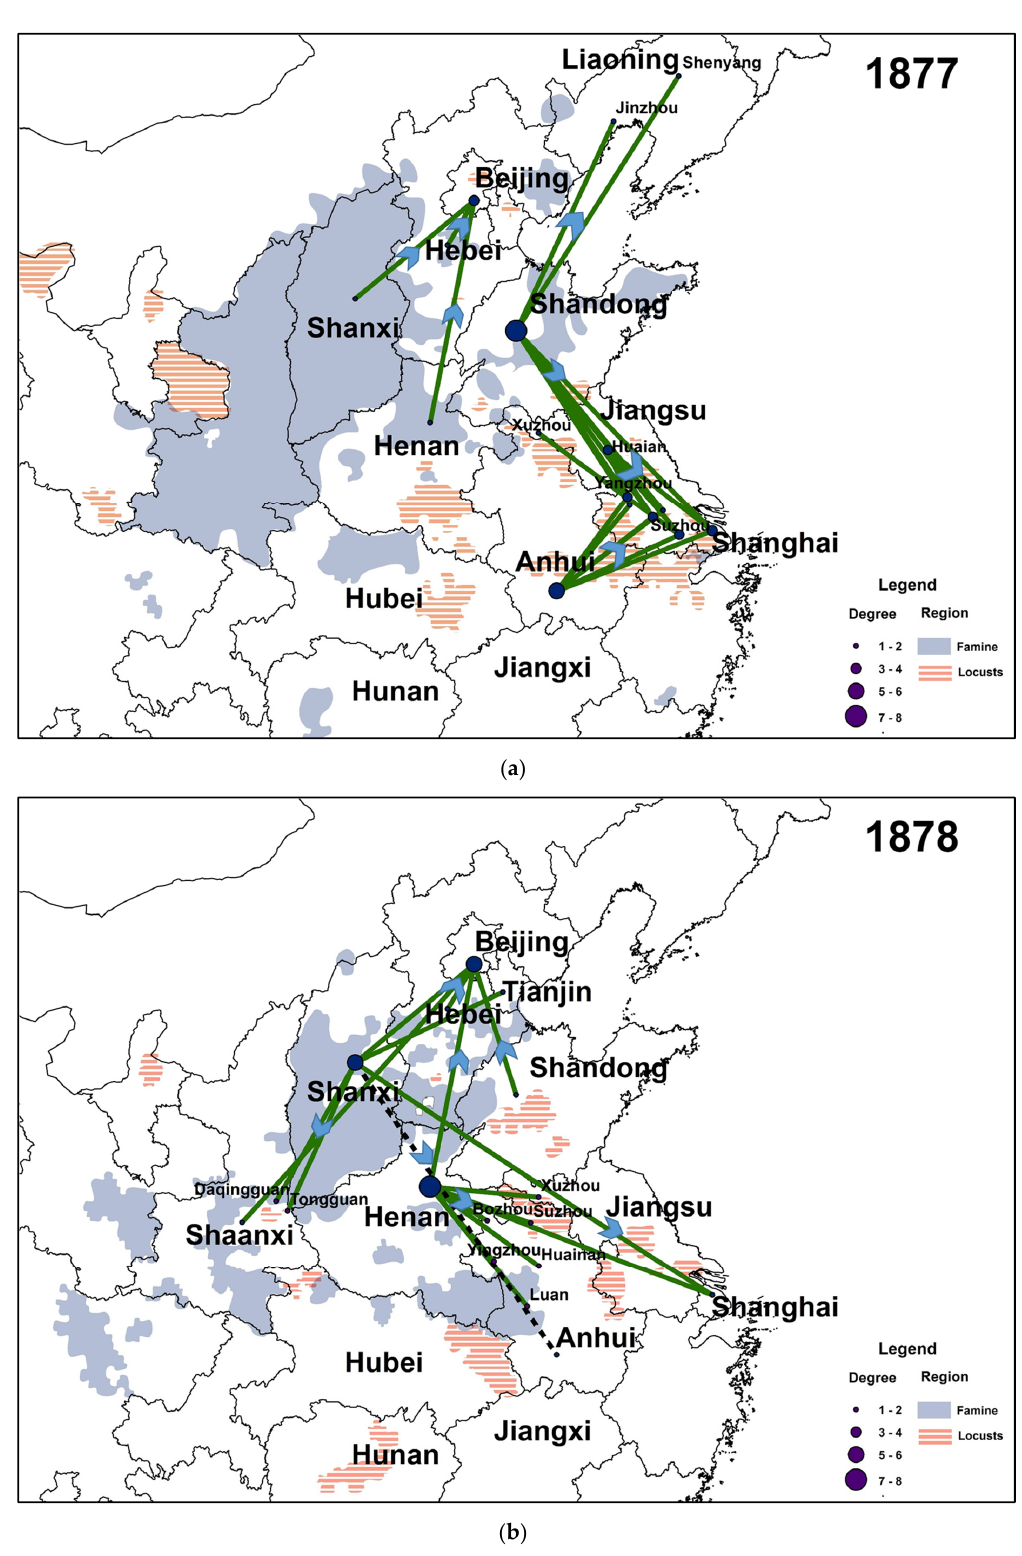
Figure 4. ( a ) Origins, destinations and sizes of the famine-related migration in 1877. ( b ) Origins, destinations and sizes of the famine-related migration in 1878. Straight line: migration flows with exact locations of destinations; Dotted line: migration flows with approximate locations of destinations; Degree: the number of direct links connected with a